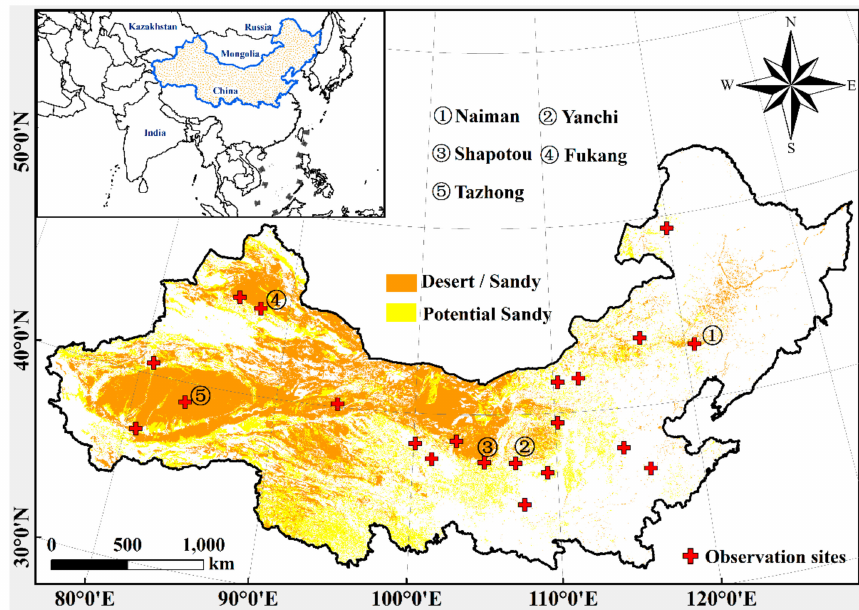
Figure 1. Map showing the location of the sandy areas in northern